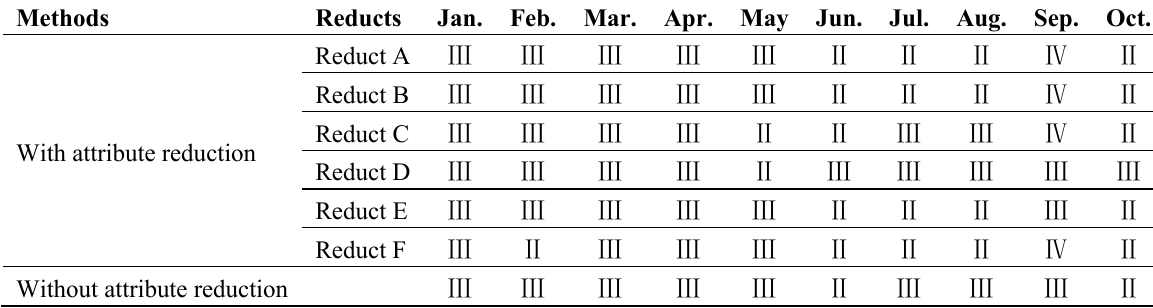
Table 5. Assessment results of the Harbin reach of the Songhuajiang River.